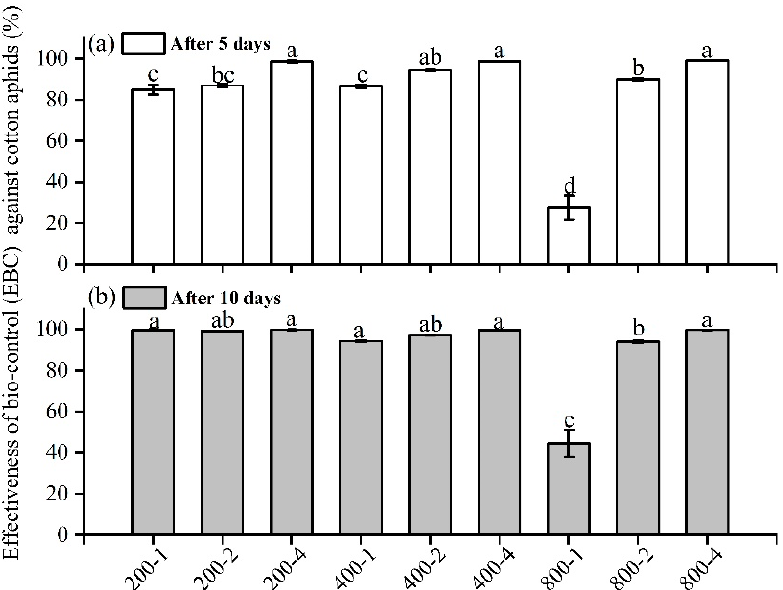
Figure 3. Effectiveness of biocontrol (EBC) against cotton aphid at ( a ) 5 days and ( b ) 10 days after releasing predators in the caged experiment in the garden (CEG) (the label in x axis presents the initial number of aphids and predators in cages). Different letters showed the mean of EBC that was different among each treatment in ( a , b ), while one-way ANOVA was used for comparison.